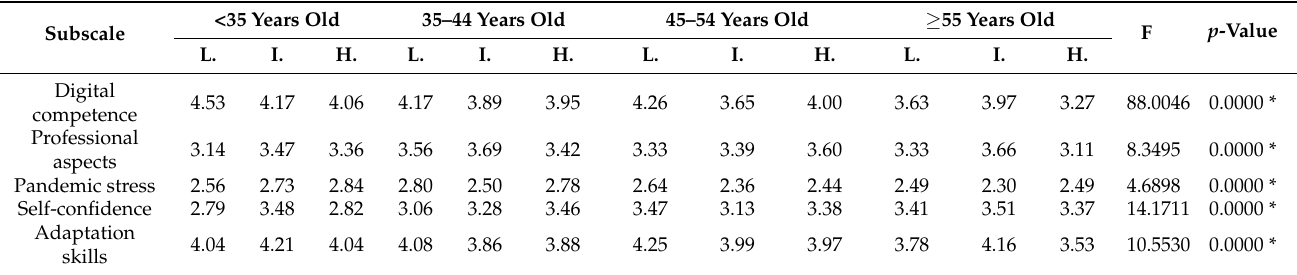
Table 7. Mean values differentiated by age and MANOVA test statistics.